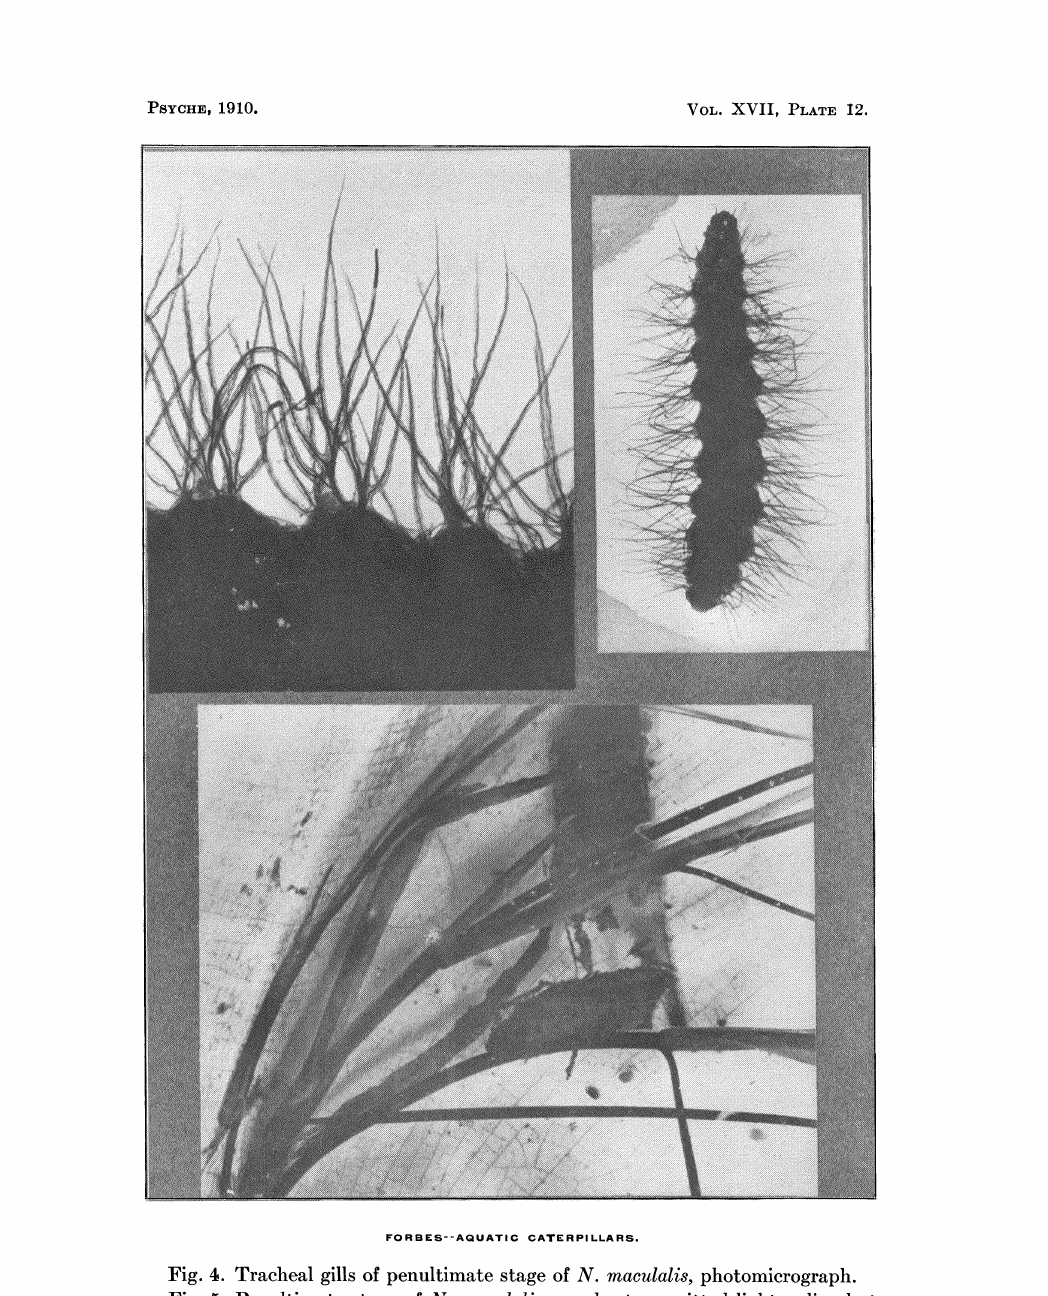
Fig. 4. Tracheal gills of penultimate stage of N. maculalis, photomicrograph. Fig. 5. Penultimate stage of N. maculalis seen by transmitted light; alive but stupefied with chloratone. Fig. 6. Cocoon of N. icciusalis on submerged stem of Potamogeton; enlarged about two